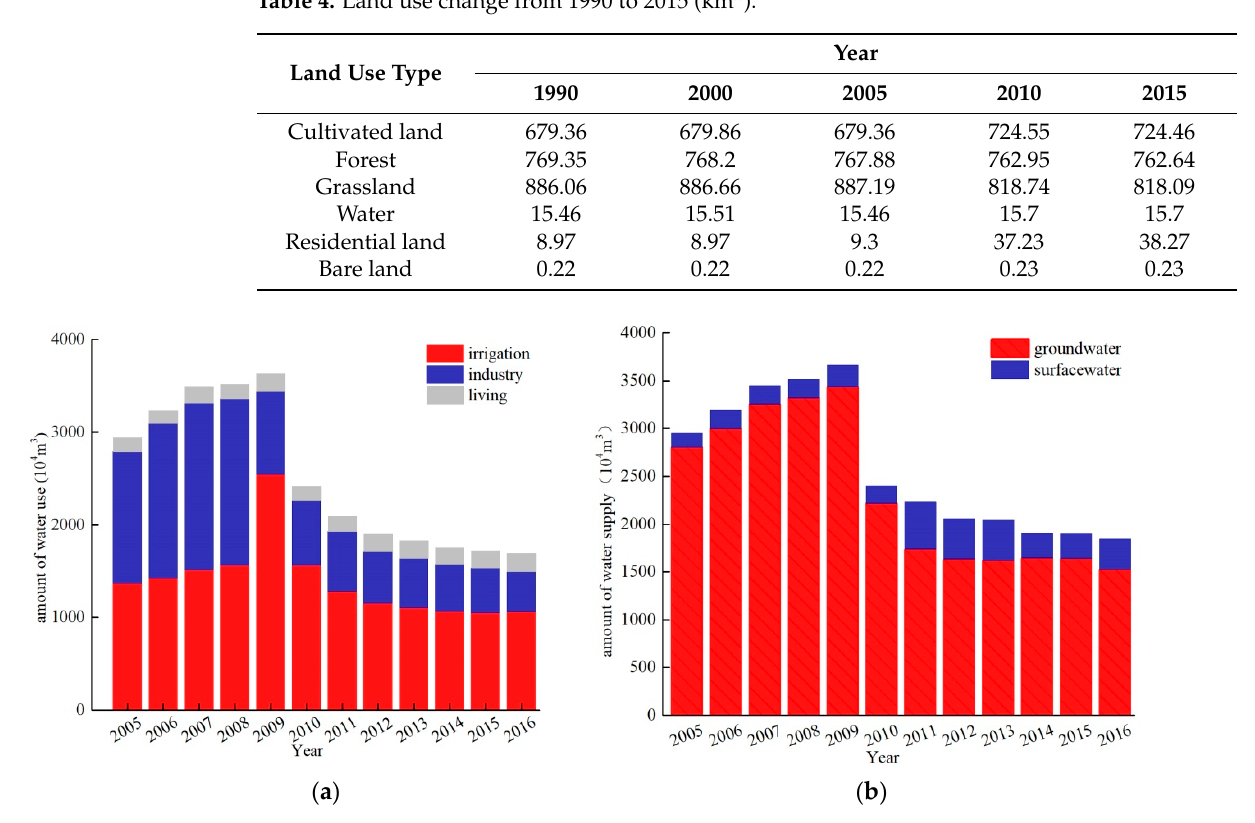
Table 4. Land use change from 1990 to 2015 (km 2 ).